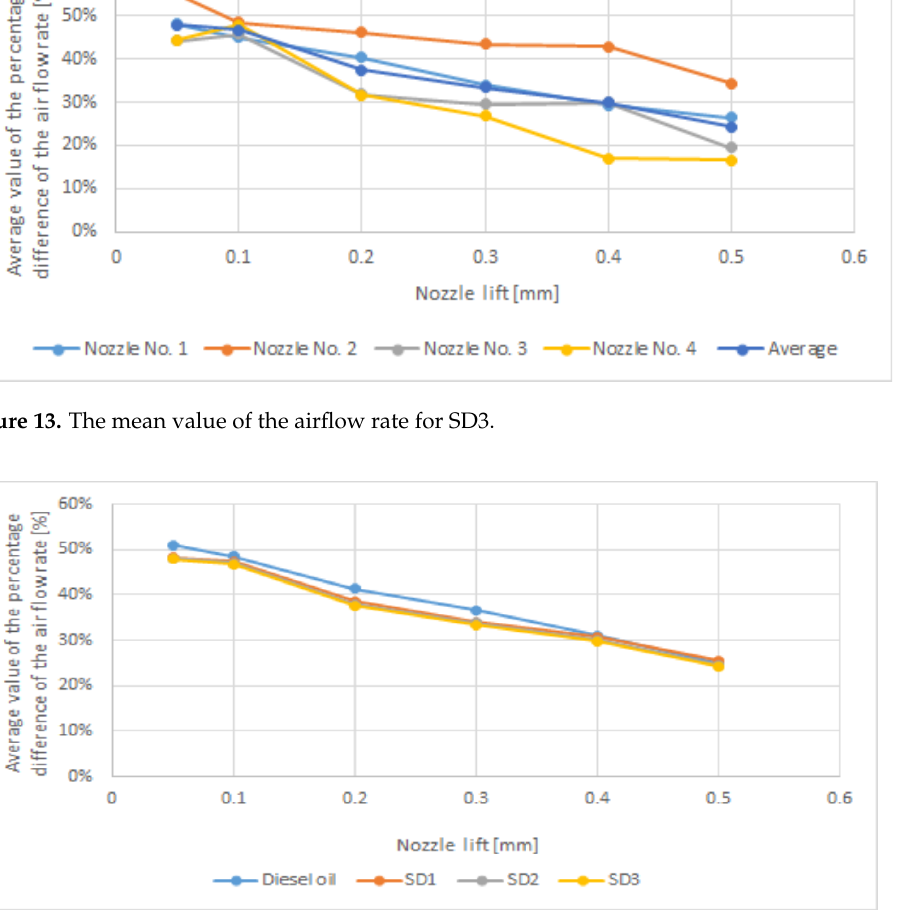
Figure 14. The mean value of the difference in the airflow rate through the injectors obtained from the CEC test PF-023.